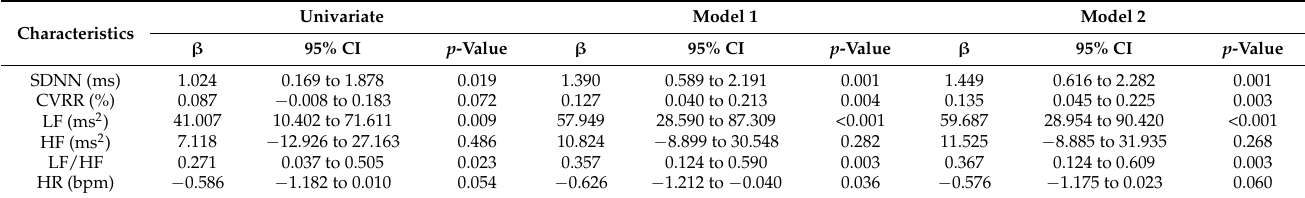
Table 5. Analysis of the association between HRV parameters and the relative count (%) of Lach- nospiraceae incertae sedis